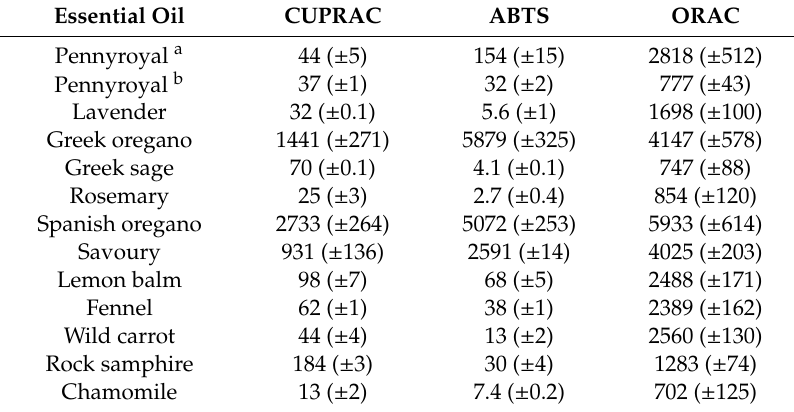
Table 3. Comparison of the antioxidant capacity of the 13 essential oils investigated in the present study. Presented results correspond to Trolox equivalent antioxidant capacity (in µ mol mL − 1 ), as measured by CUPRAC (cupric reducing antioxidant capacity), ABTS (2,2 (cid:48) -azino-bis(3-ethlybenzthizoline-6-sulphonic acid radical scavenging) and ORAC (oxygen radical absorbance capacity)